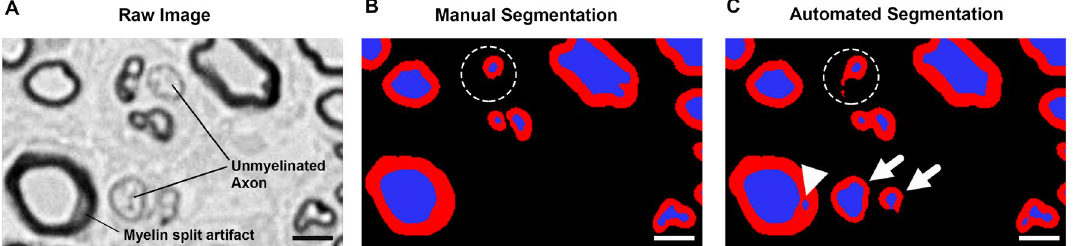
Figure 2. Automated axon identification. ( A ) Part of a cross-section of a rat tibial nerve in a late regeneration stage, 12 weeks post-surgery, 7 mm distal to the nerve coaptation. Myelinated axons are shown as black circles. Osmium tetroxide postfixed, epoxy embedded, 1 µm thickness. A myelin split artifact and prominent unmyelinated axons are present in this section. ( B ) Manual segmentation of the image in A by a blinded investigator. Myelin split artifacts and unmyelinated axons are correctly classified. Although an irregularly shaped, compressed nerve fiber is correctly identified as such, its myelin sheath is not fully segmented (dashed circle). ( C ) Automated segmentation of the image in A using AxonDeepSeg. The myelin split artifact (white arrowhead) as well as prominent unmyelinated axons (white arrows) have been misinterpreted as myelinated axons. Myelin sheaths are shown in red and axons are shown in blue. Scale bar represents 5 µm. (Own illustration created with AxonDeepSeg). Precision (POS. predictive Sensitive Axons False False value) Group Axons present detected True positives positives negatives